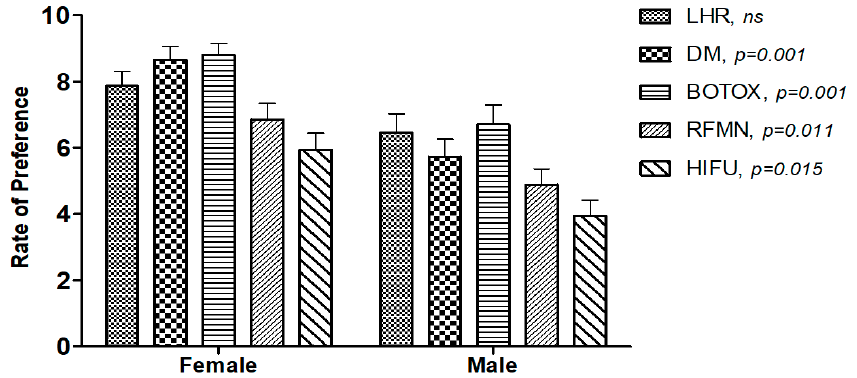
Figure 7. Effectiveness of cosmetic procedures as rated by participants.